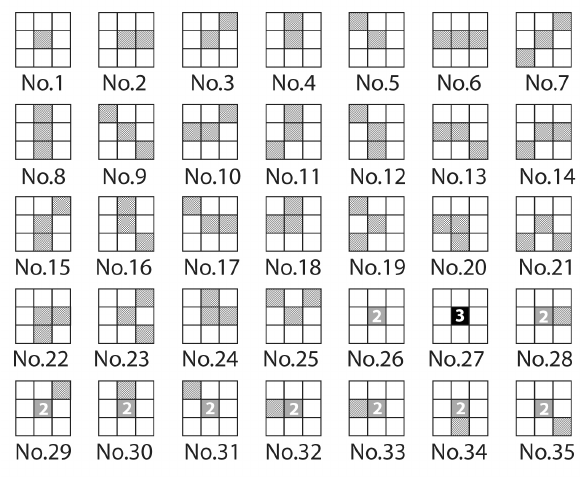
Figure 3. Feature mask patterns of